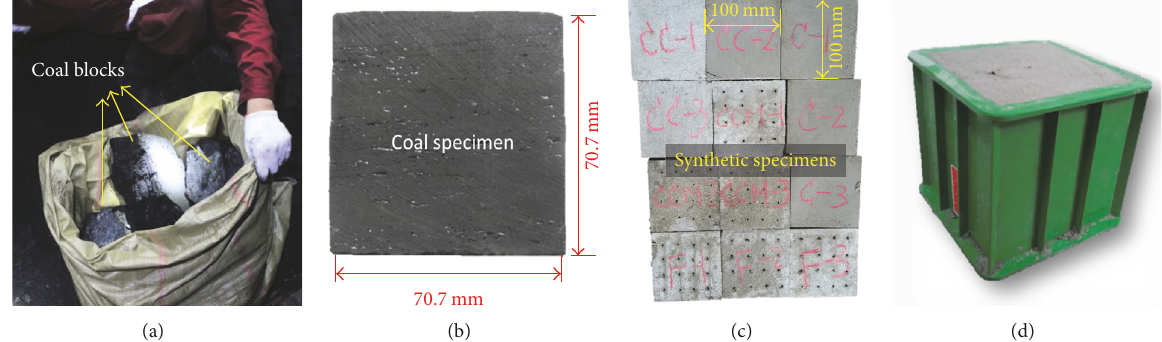
Figure 4: Coal blocks and specimens. (a) Coal blocks which are taken from the in situ working face; (b) coal specimens (70.7 × 70.7 ×